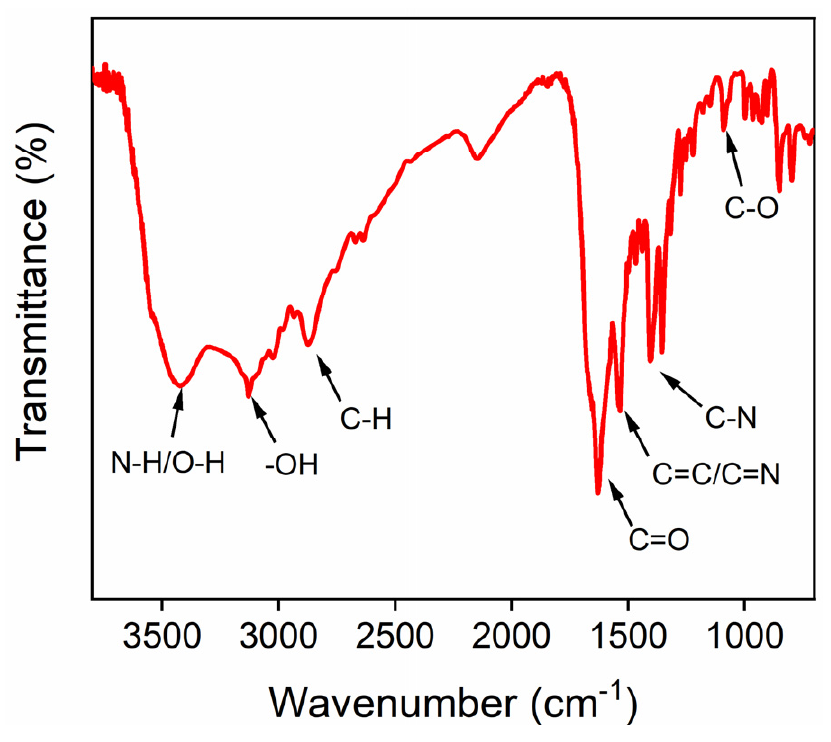
Figure 4. FT-IR spectrum of CDs.